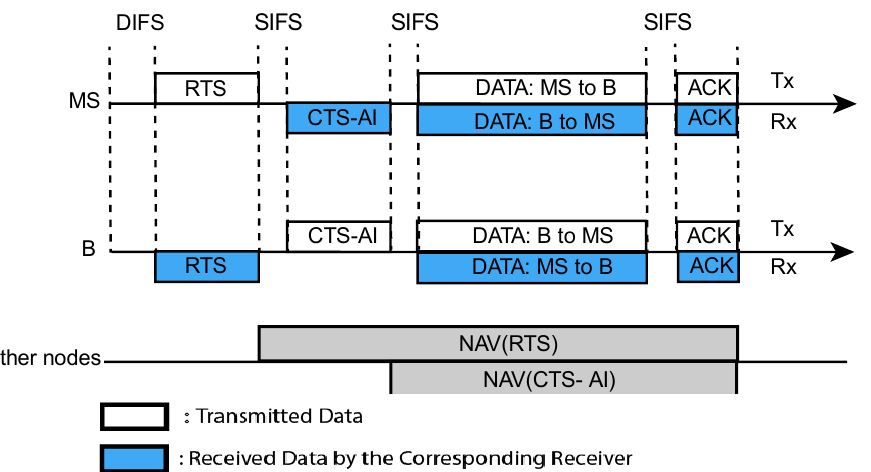
Figure 5. Time sequence of the proposed MAC for BFD (the MS initiates the transmission). TNFD Communications